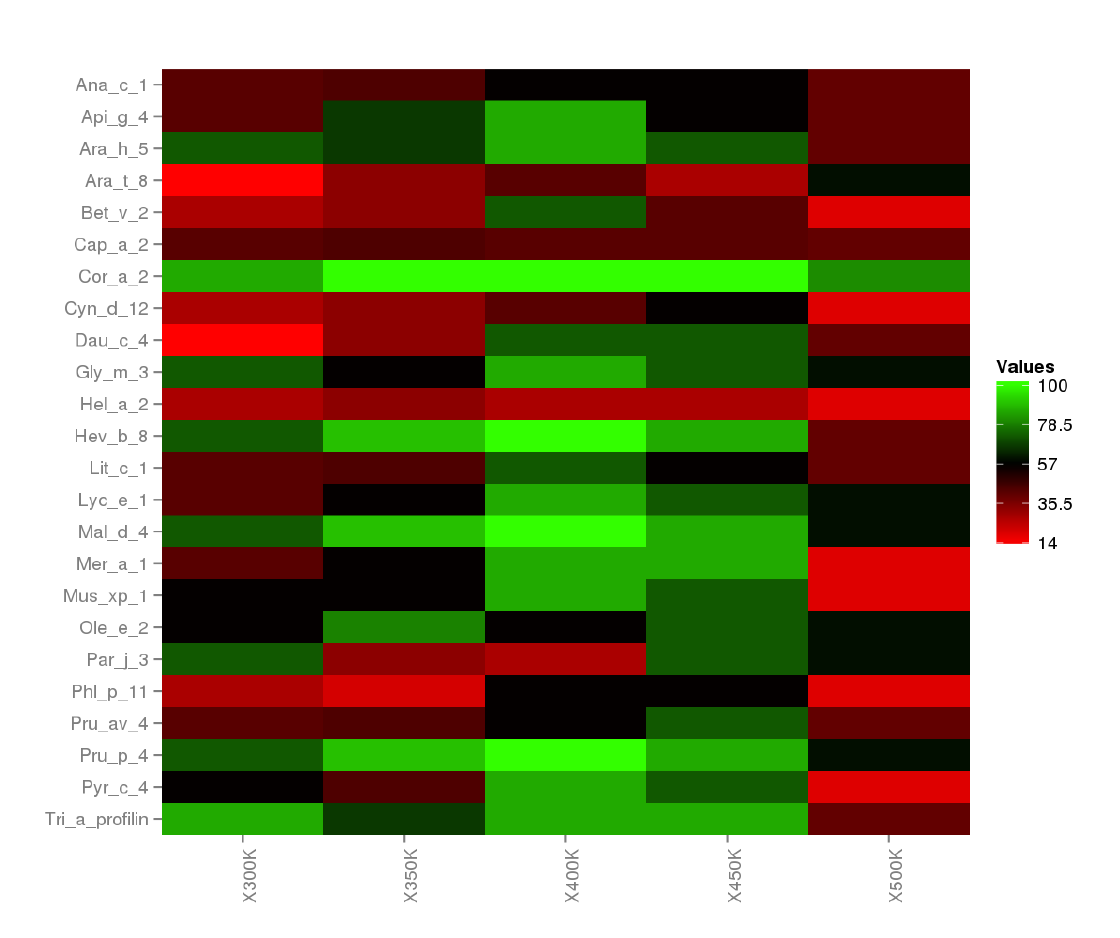
Figure 6. Heat plot. The cross-reactivity of Cor a 2 and 24 allergens are representants by the percentage of predominance; where 100% (green color) indicates that all epitopes are shown for a particular allergen and a given